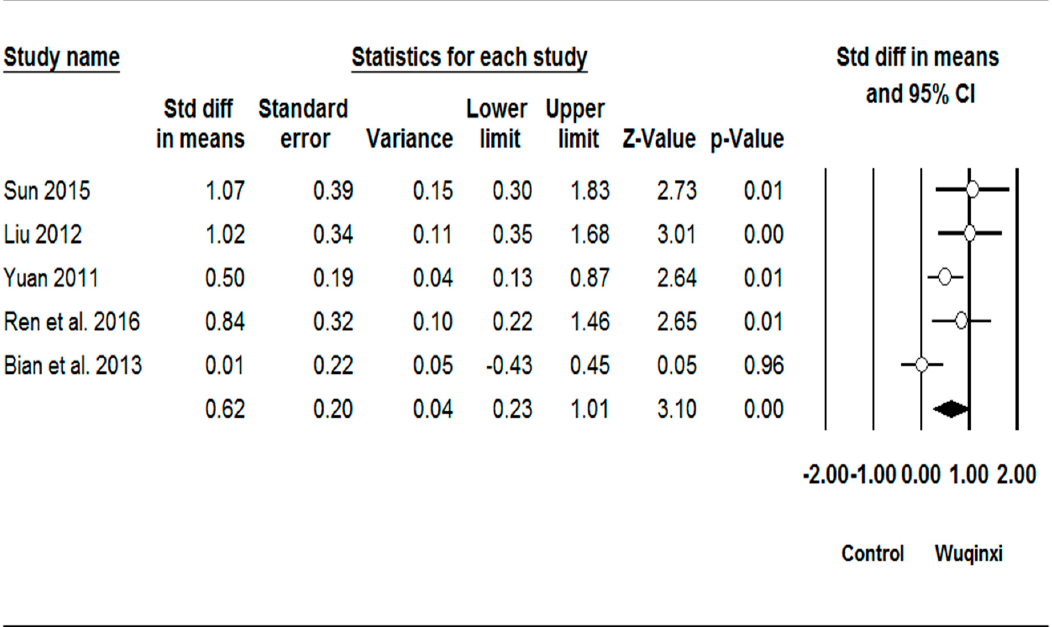
Figure 3. Effect of Wuqinxi on diastolic blood pressure. Effect size (95% CI) of each study is denoted by circle (black line). The mid-point of the circle represents the point effect estimate, meaning effect estimate for each study. The area of the circle represents the weight given to the study. The diamond below the studies represents the overall effect.